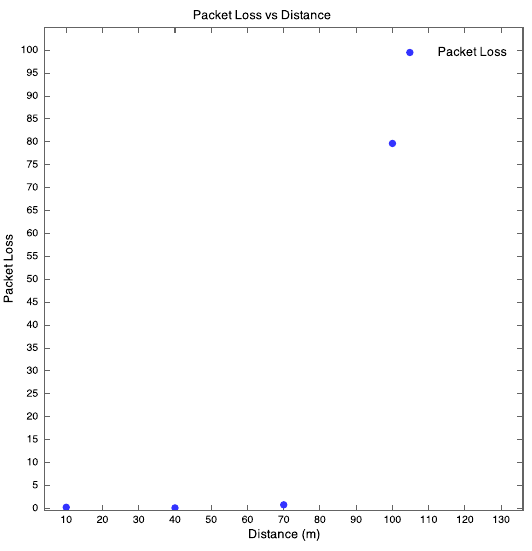
Figure 5. Packet Loss vs. Distance for Experiment